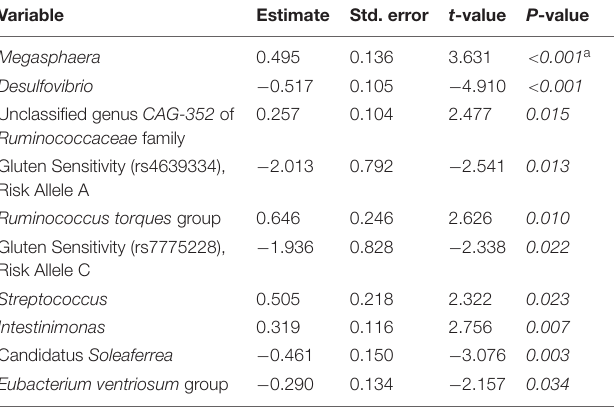
TABLE 5 | Reduction in summative FGID symptom severity linear model: demographics + genomics + microbiome (D + G + M). Variable